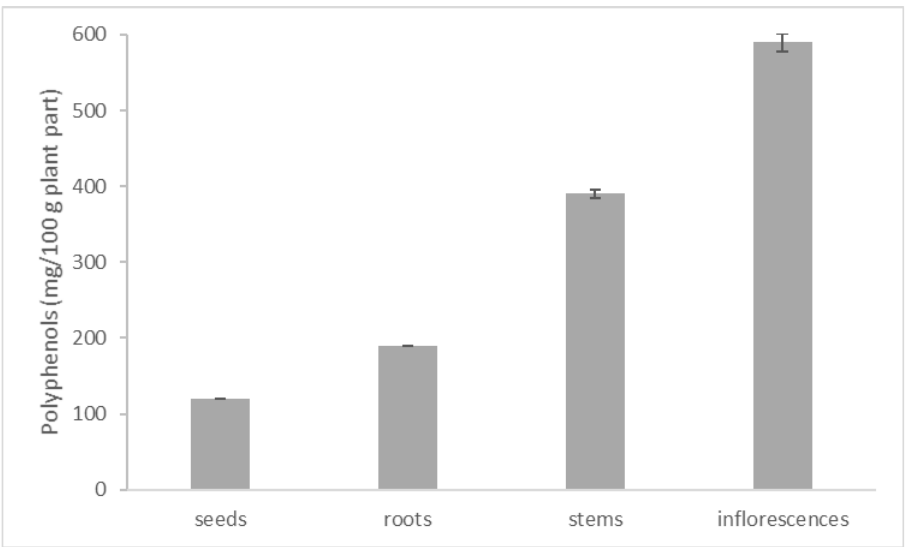
Figure 1. Total polyphenols detected in the aqueous extracts of the various L. multiflorum organs.